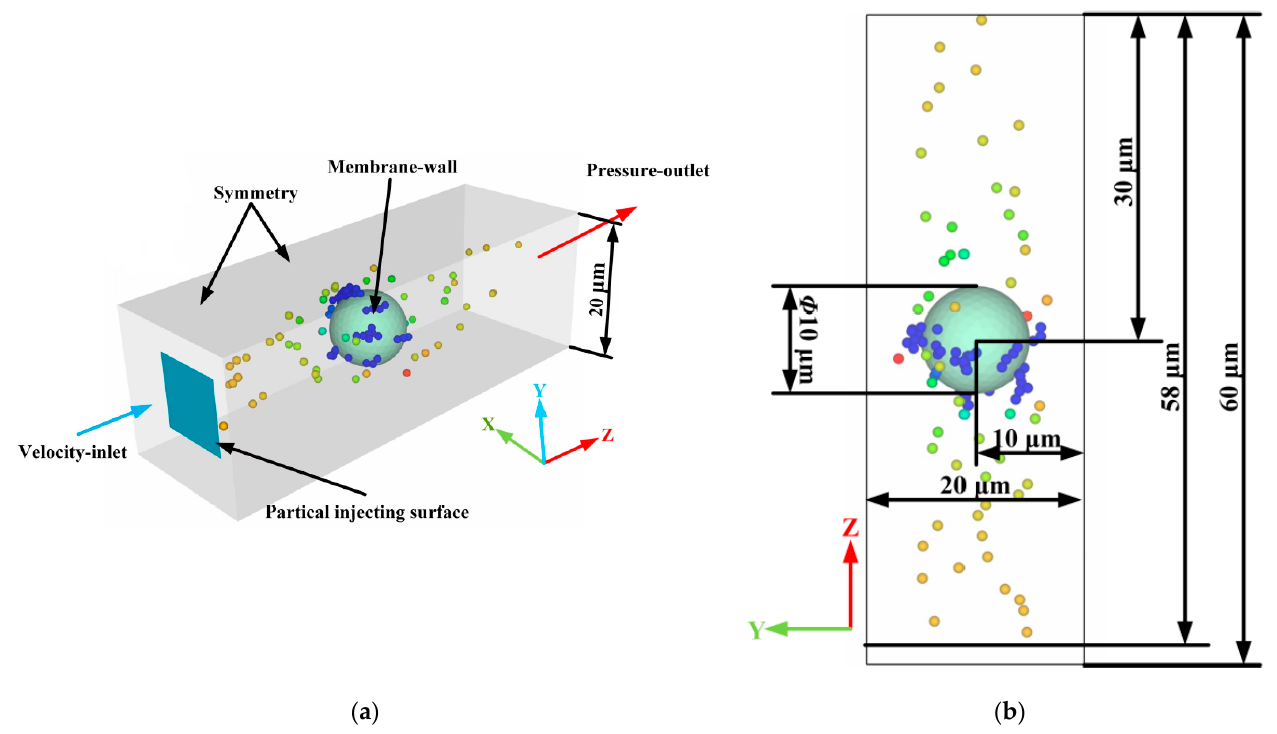
Figure 2. Pore structure of the ceramic membrane and the size of the computational domain. ( a ) Isometric view; ( b ) YZ plan view. Table 1. Physical parameters.